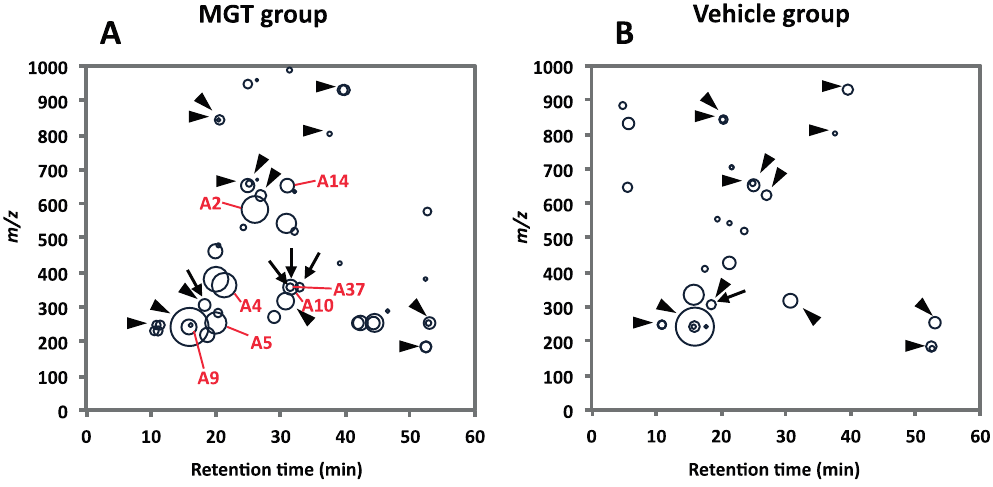
Figure 1. Comprehensive DNA adducts analysis. Map views of DNA adducts in lungs of mice with ( A ) or without MGT-exposure ( B ). Arrow heads indicate the DNA adducts observed in both MGT and vehicle groups, and arrows indicate the corresponding DNA adducts observed in in vitro model reactions, including oxidized arachidonic acid, oxidized linoleic acid or hydroxy radical with ctDNA (see additional files 1 and 3). The 7 major contributors determined by PCA and RF analyses are indicated by A2, A4, A5, A9, A10, A14 and A37,